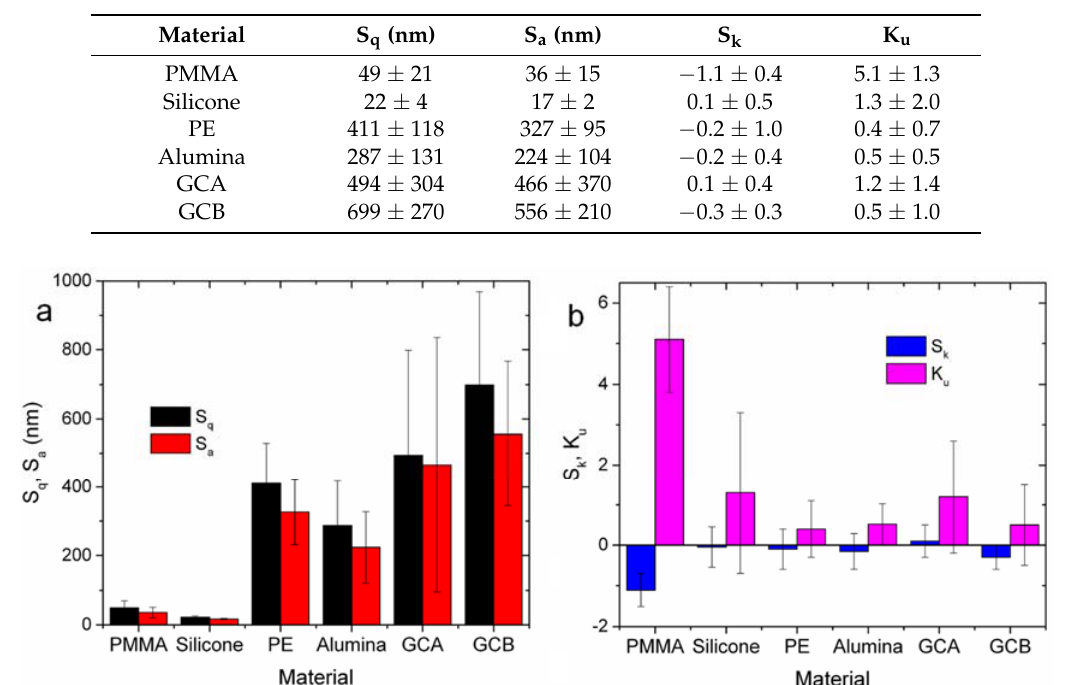
Figure 4. Image of additional data channel taken by AFM on GCA, simultaneously with the height one in Figure 3e: the scale reports the mean deviation in oscillation amplitude between trace and retrace scan. Table 2. Numerical values obtained by the topographical analysis; these data are represented in graphical form in Figure 4.